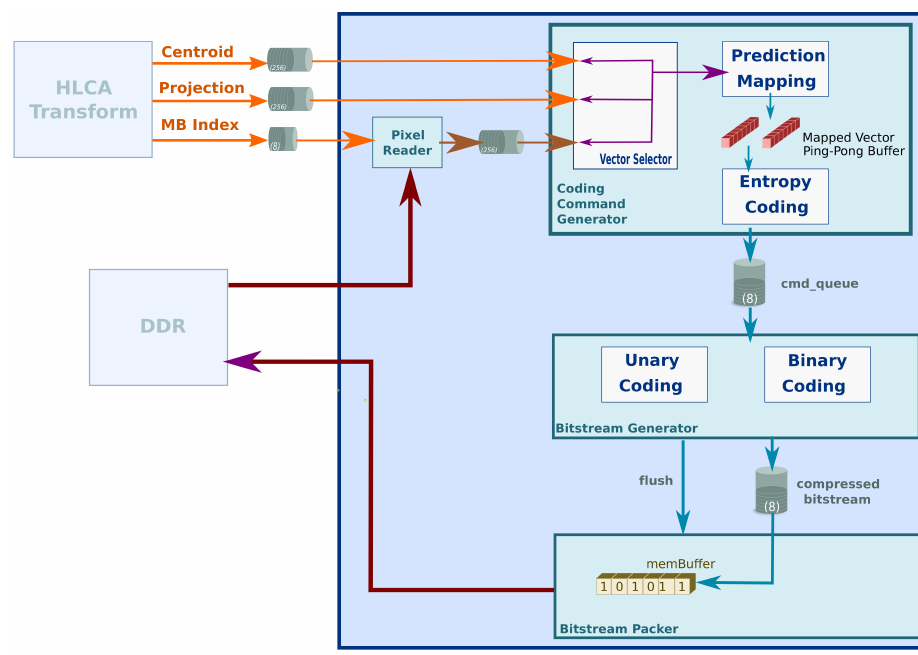
Figure 9. Overview of the HyperLCA Coder hardware